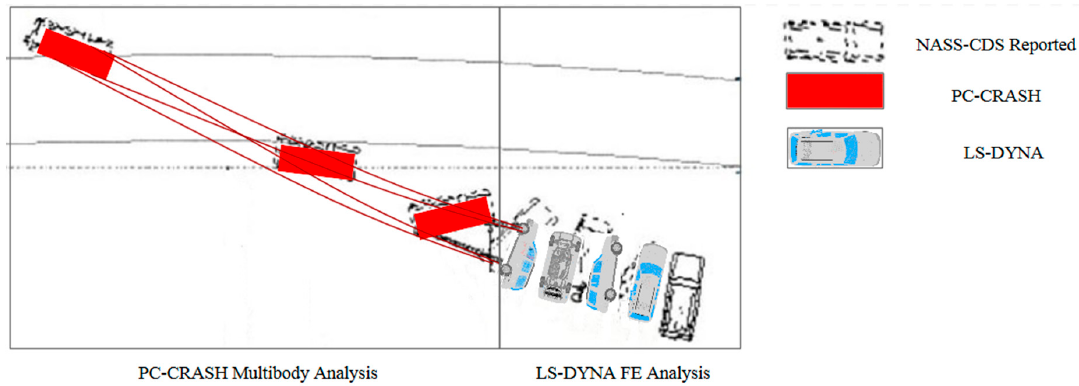
Figure 1. Overlay of the PC-CRASH the LS-DYNA simulations, and the NASS-CDS scene diagram. Table 3. Vehicle kinematics at the point of trip.